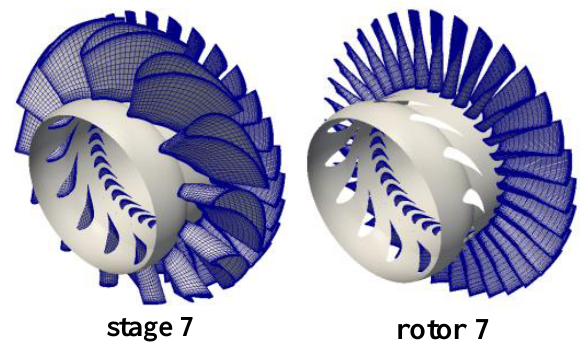
stage exit swirl angles are near 0. The obtained velocity vectors are regular (Fig. 13, 14). The Figure 11. Meridional section of turbine 2 Figure 11: Meridional section of turbine 2 flow efficiency of the turbine is equal to 84.2 % (the tip leakage loss is not included). Таble 2. Geometric characteristics of the blading system for turbine 2 Figure 13. Velocity vectors colored by Mach number in a meridional section at the mid blade-to-blade distance of stage 7